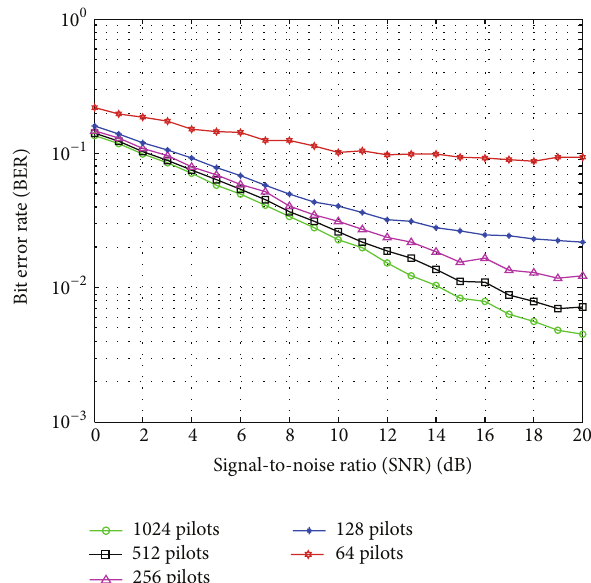
Figure 8: BER performance versus SNR for the FBMC/OQAM system with different number of pilot symbols. 𝑀 = 2048 and 𝑇 = 0.0167 . 𝑓 𝑑 𝑠